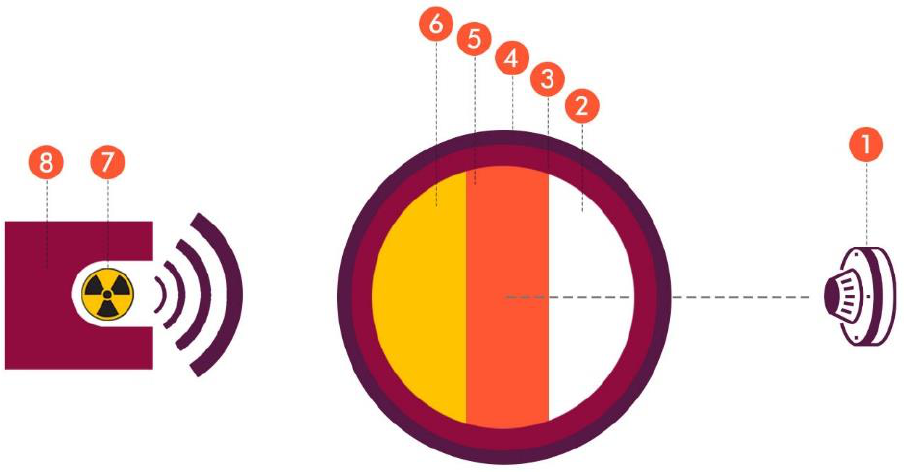
Figure 1. The proposed structure of the detection system: 1-NaI detector, 2-gas phase, 3-scale, 4-steel pipe, 5-water phase, 6-oil phase, 7-dual-energy gamma source, and 8-protective case.